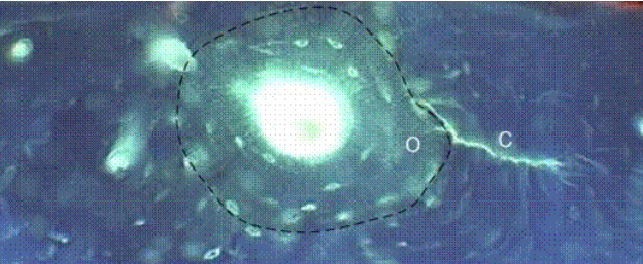
Figure 5: Image taken using optical fluorescence microscopy of a transverse section of bone, showing a crack (C), of length approximately 100  m, whose left-hand tip has stopped growing on reaching the boundary of an osteon (O). From [21].